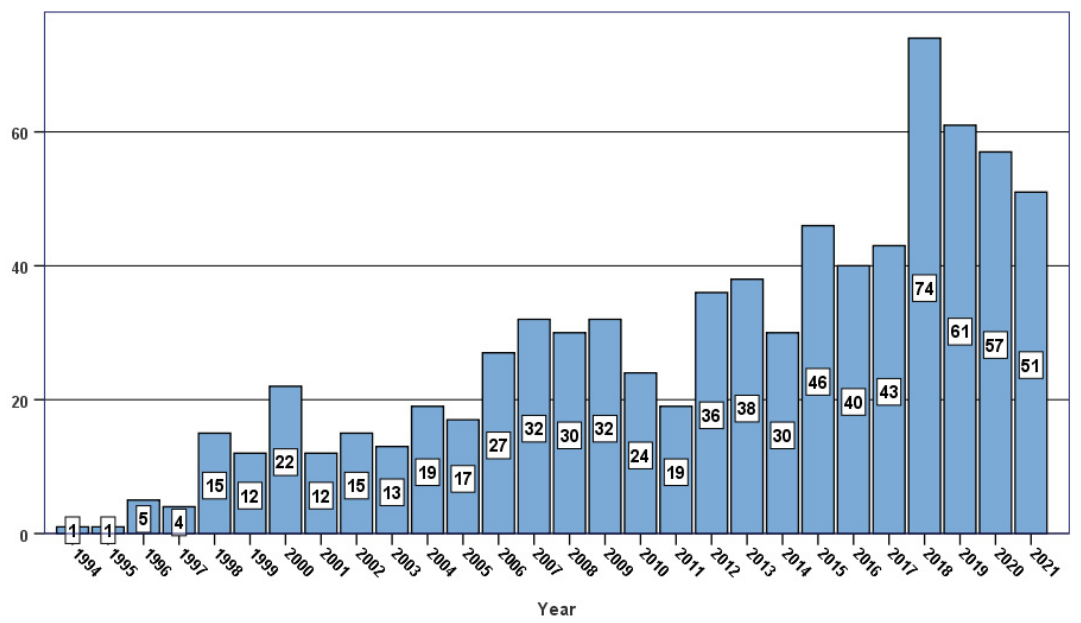
Figure 1. Number of autologous transplant procedures for the treatment of systemic sclerosis. Data as reported to the European Blood and Marrow Transplantation Society (EBMT).